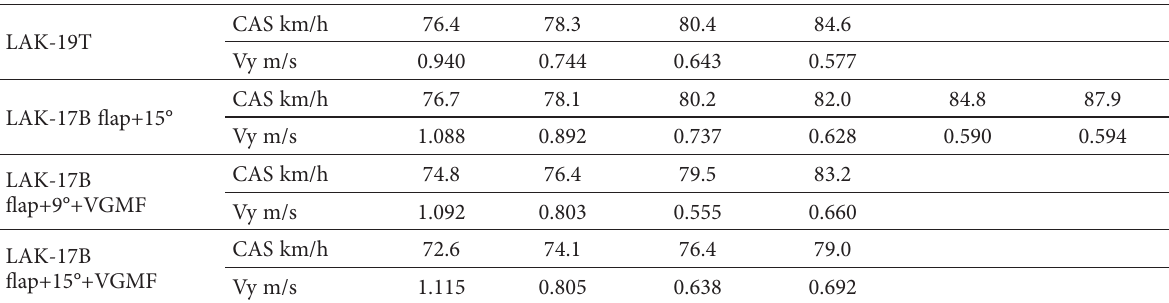
Table 1. Corrected results of the test flights (Table: P. Lauk)